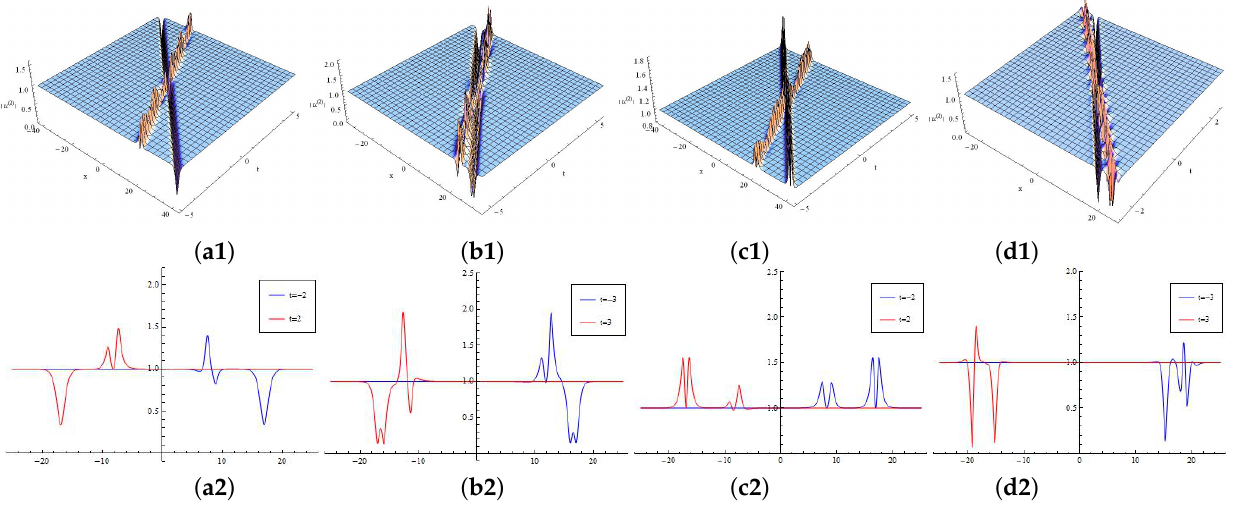
Figure 12. Interaction solution of breather and soliton for Equation (5) with (cid:101) = 1, a = − 1, b = 2: ( a ) interaction of M-shaped double-peak-breather and dark soliton with λ 1 = 1 tion of M-shaped double-peak-breather and W-shaped soliton with λ 1 = 1 of M-shaped double-peak-breather and M-shaped soliton with λ 1 = 1 double-peak-breather and dark soliton with λ 1 = 1 + i For the nonlocal defocusing gSS equation with (cid:101) = 1, a = 1, b = 1 d 12 = 0, d 13 = 3, d 21 = 1, d 22 = i, d 23 = 2, λ 1 = 1